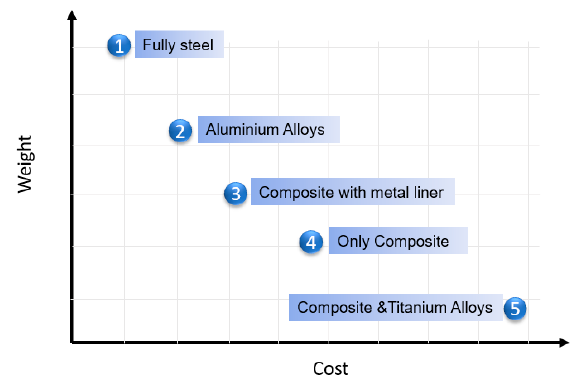
Figure 3. Cylinder design: weight vs. price [5].